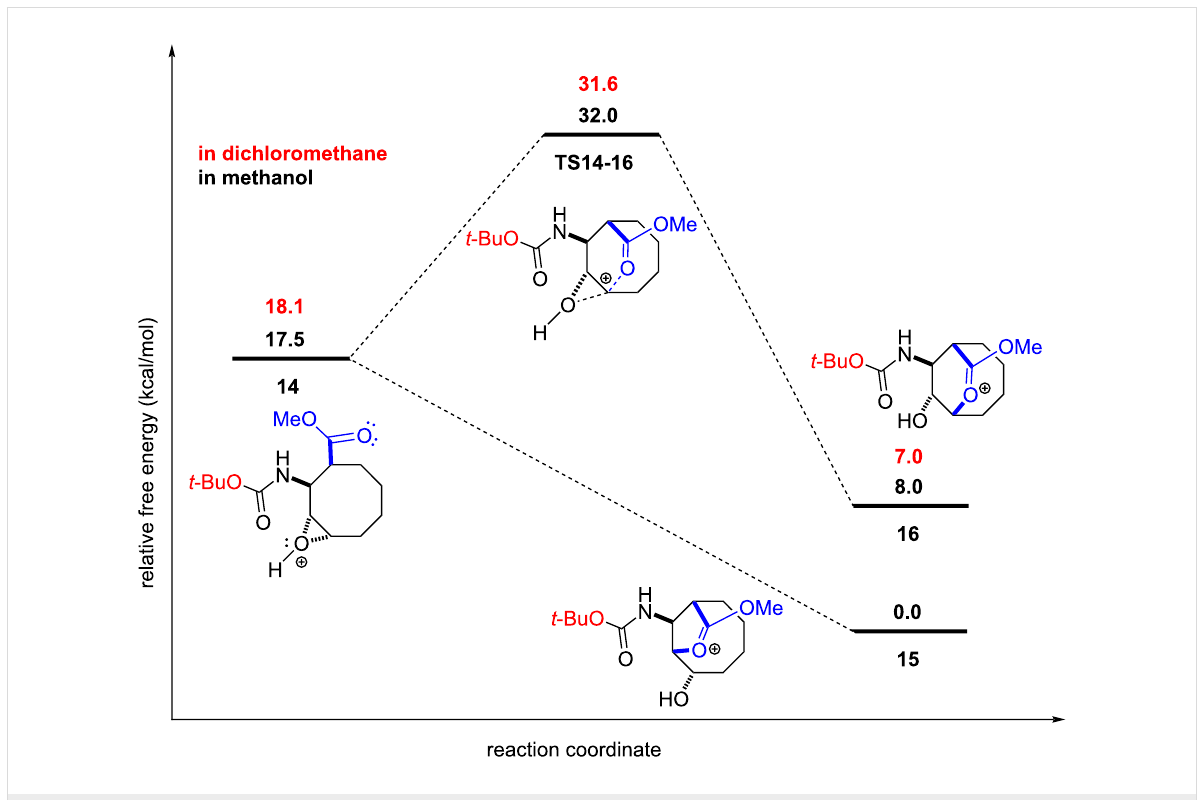
Figure 3: Solvent-corrected relative free energy profile at 298.15 K for the reaction mechanism of 14 shown in Scheme 5.